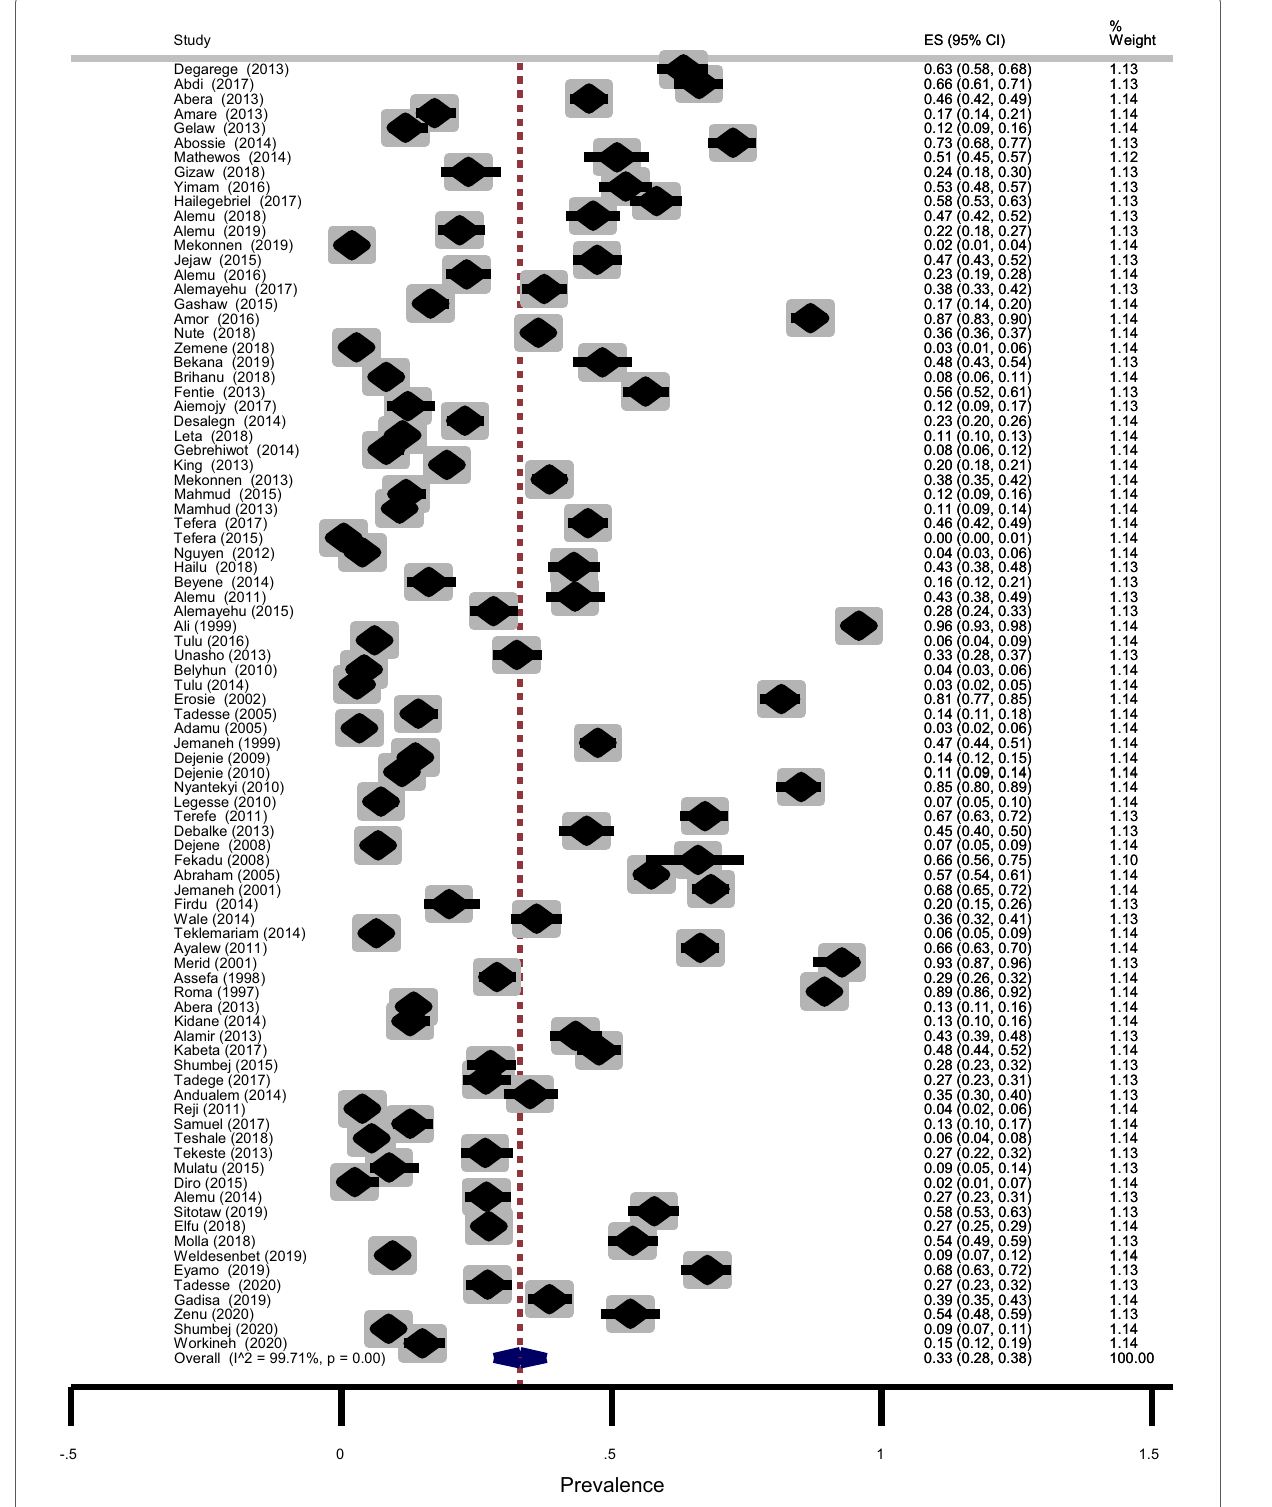
Fig. 3 Forest plot showing pooled prevalence of